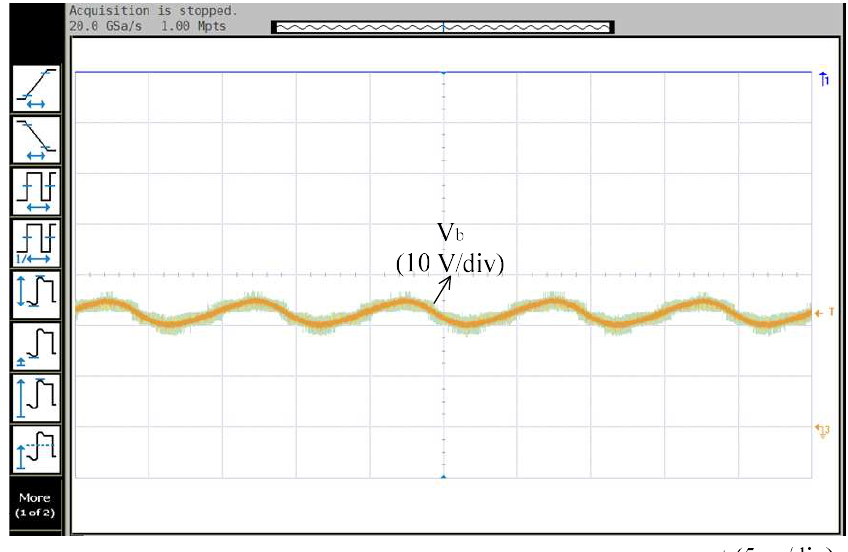
Figure 14. The waveform of buck voltage, V b